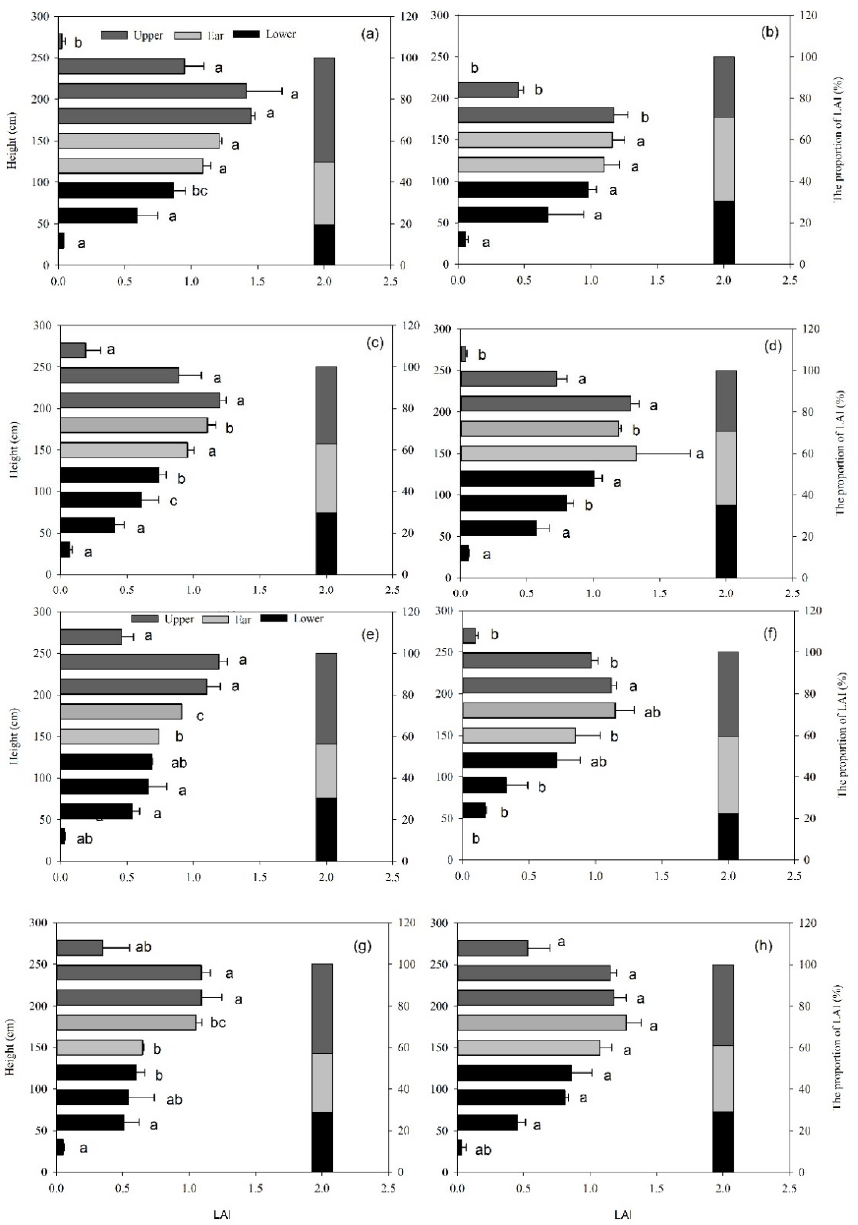
Figure 2. The vertical distribution of maize leaf area index (LAI) under difference treatments, re ‐ spectively, and the data was all collected in 2018 ( a – d ) and 2019 ( e – h ). Sub ‐ graphs ( a ) and ( e ) indicate treatment OM; sub ‐ graphs ( b ) and ( f ) indicate treatment OM ‐ F; sub ‐ graphs ( c ) and ( g ) indicate treatment OM ‐ D; sub ‐ graphs (d ) and ( h ) indicate treatment OM ‐ S. The gray bar represents the LAI of ear layers, dark gray and break bars represent the LAI of upper and lower ear layers respectively. Different small litters indicate significantly different at 0.05 probability level among the treatments.